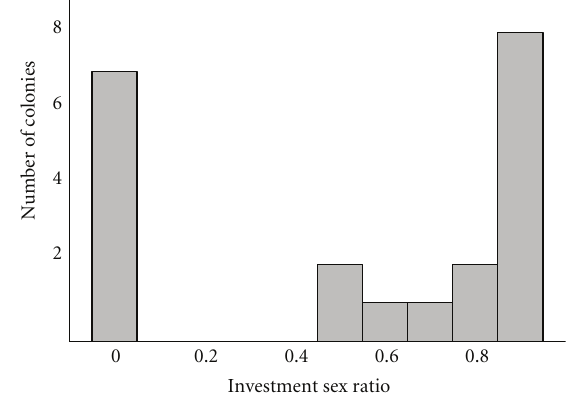
Figure 4: Distribution of colony-level sex ratios (female) for field- collected colonies without a queen based on data from Table 3. Colonies with a sex ratio of 0 produce only male